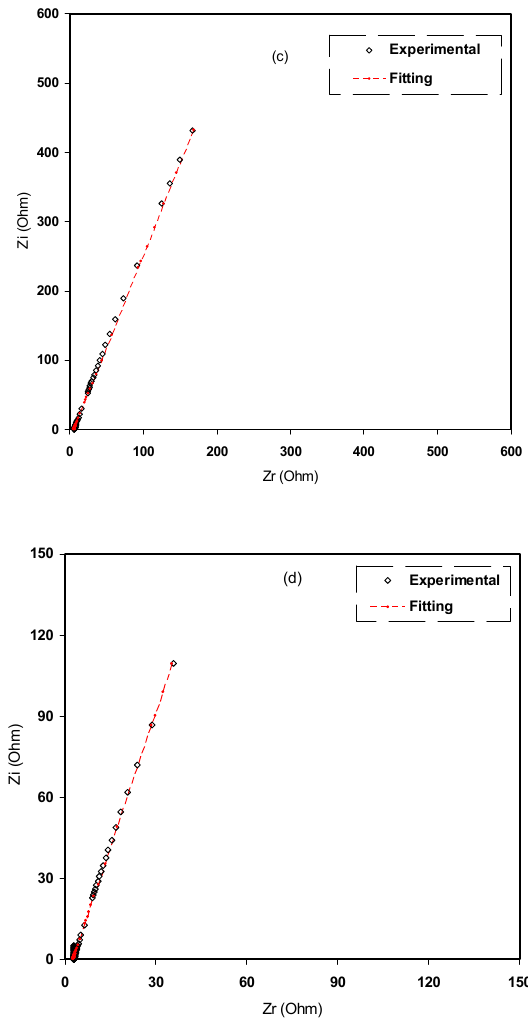
Figure 7. Experimental impedance and EEC fitting plots for ( a ) CMCF1, ( b ) CMCF2, ( c ) CMCF3 and ( d ) CMCF4 blended films at ambient temperature. Table 1. DC conductivity for pure CS:MC and blend electrolyte films at room